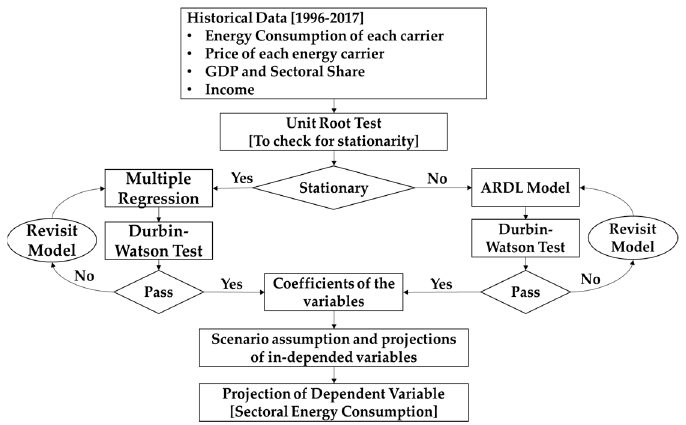
Figure 3. The framework of the econometric analysis of demand in this study.